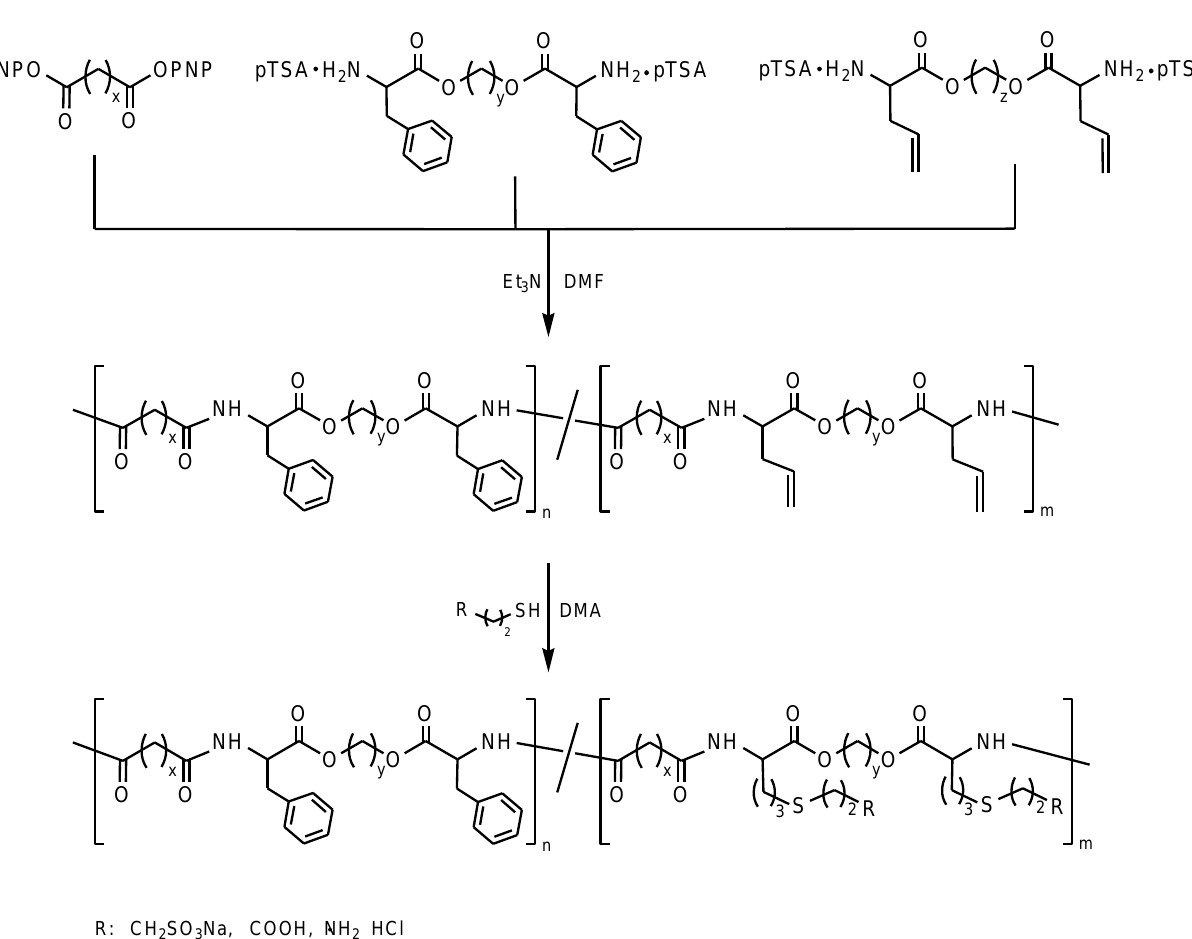
Figure 13. Synthesis scheme for the preparation of poly(ester amide)s derived from amino acids and having pendant carbon–carbon double bonds and subsequent carboxylic acid, amine, and sulfonate